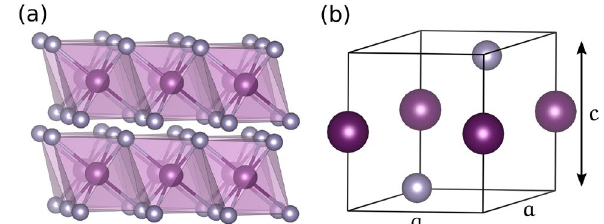
Figure 1. Crystal structure of BaSn 2 , Ba (Sn) atoms in purple (grey). ( a ) Side view of the layered structure of BaSn 2 , where Sn atoms octahedrally coordinate the Ba cations. ( b ) Unit cell of BaSn 2 . Uniaxial pressure is applied along the depicted off-plane c direction.